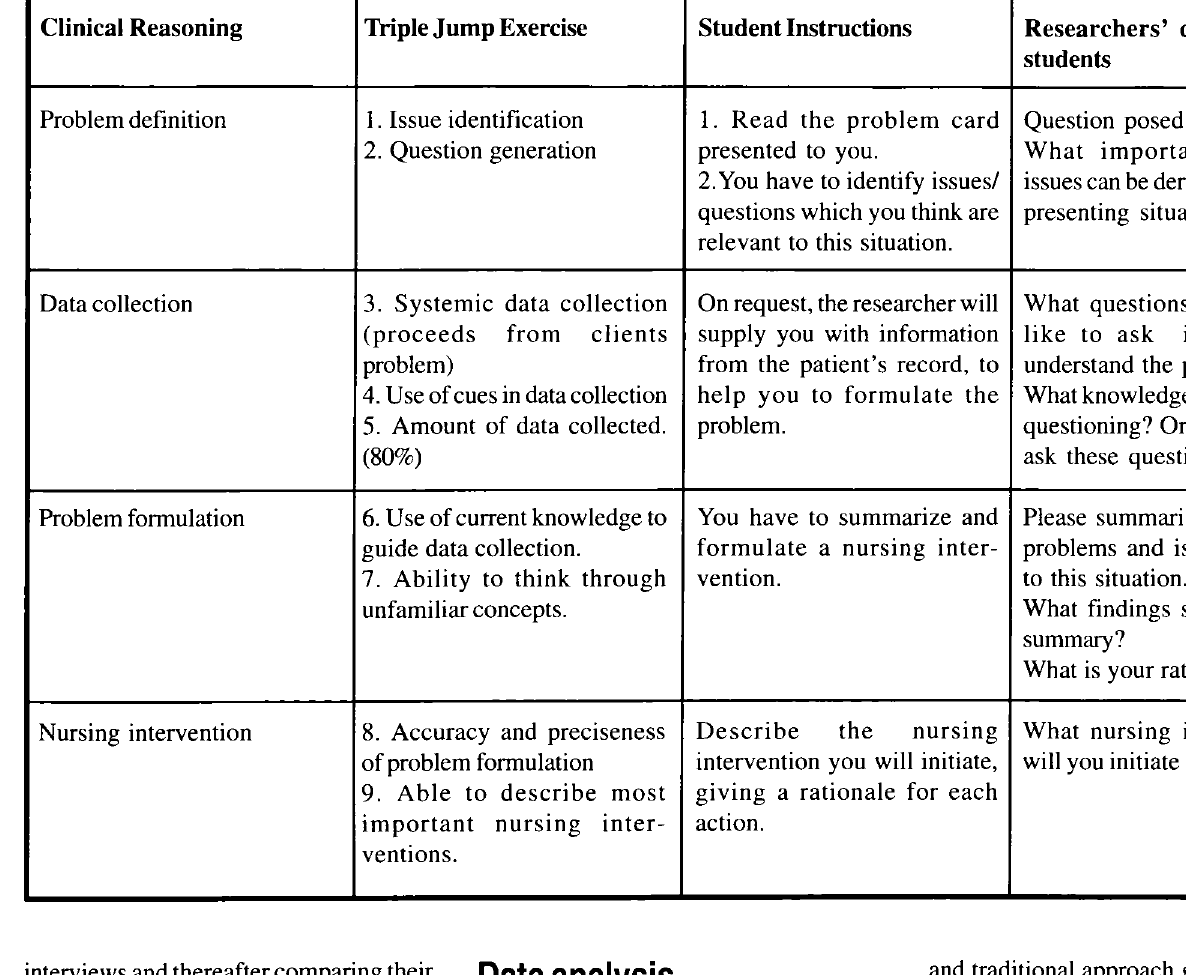
It is about 2000 hours, Mrs Zaza has been brought in the casualty department where you are working. She complains of severe pains, looks pale, cold and has a splinted left fore